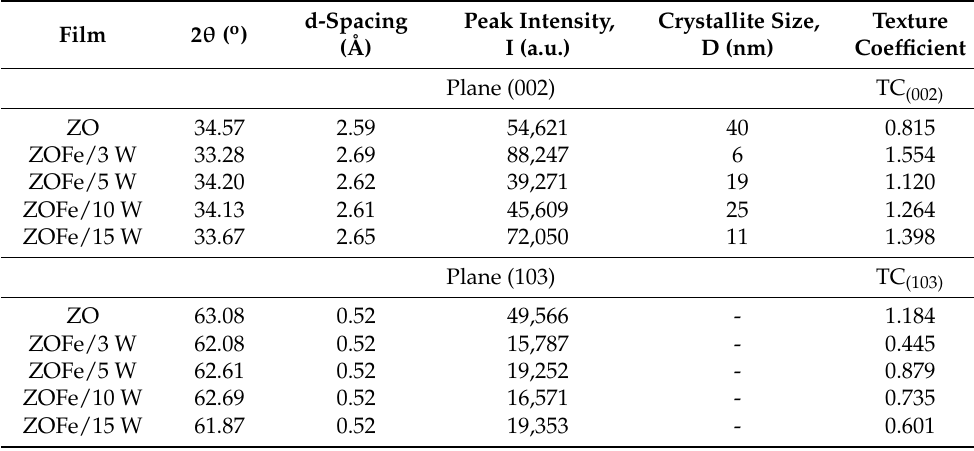
Figure 2. GIXRD patterns of ZO and ZOFe thin films deposited on SiO 2 . Table 3. Planes angle 2 θ , d-spacing, intensity I, crystallite size D, and texture coefficient TC for different DC depositing powers of sputtered ZO and ZOFe from